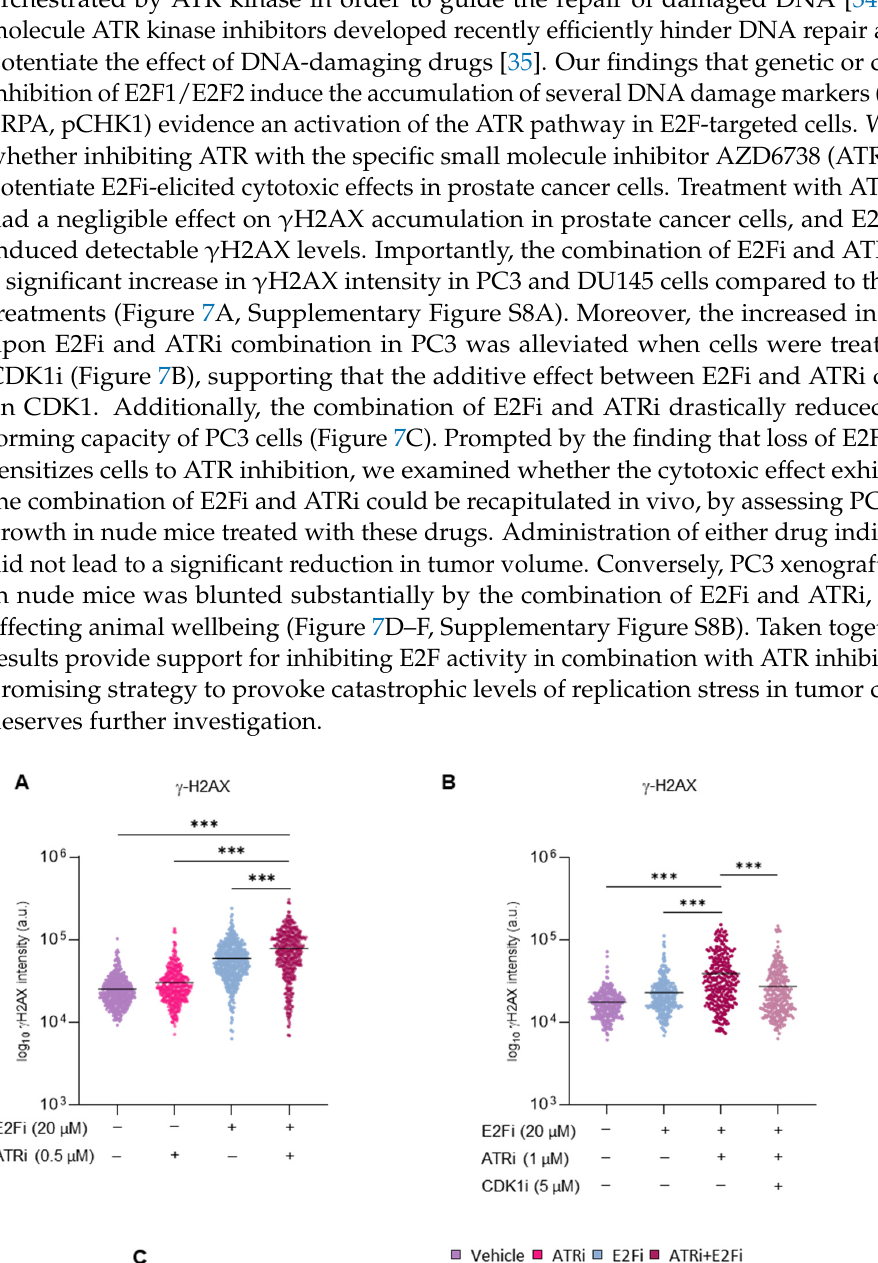
Figure 7. Combination of E2Fi and ATRi enhances genomic instability and reduces cell growth in PC3 cells in vitro and in xenografts. ( A ) Intensity of γ H2AX signal in cells in S phase 24 h after the indicated treatments. Data of 500 cells from one representative experiment of 3 independent exper- iments are shown. Data are expressed as Log10 intensity. Horizontal bars mark mean intensity. Sta- tistical analysis was performed using ANOVA and Fisher’s test. *** p < 0.0001. ( B ) Intensity of